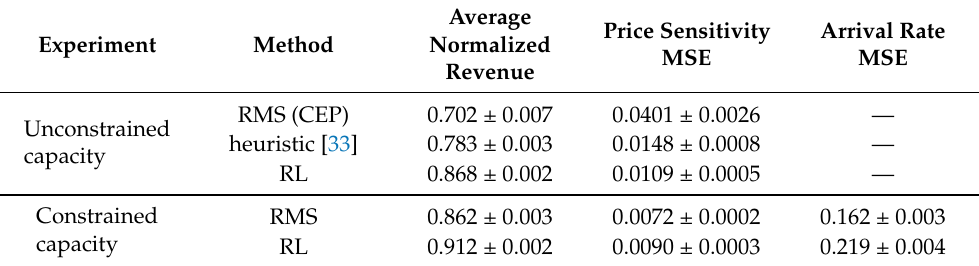
Figure 10. Comparison between revenue management system (RMS) ( left ) and reinforcement learn- = 2.9. The reinforcement learning policy performs ing (RL) ( right ) roll out policies for ν ∗ = 70 / 22, F ∗ 5 better (89.9%) than the revenue management system policy (80.6%) with respect to the revenue performance but has worse mean squared errors for both demand model parameters. Table 3. Summary of experimental